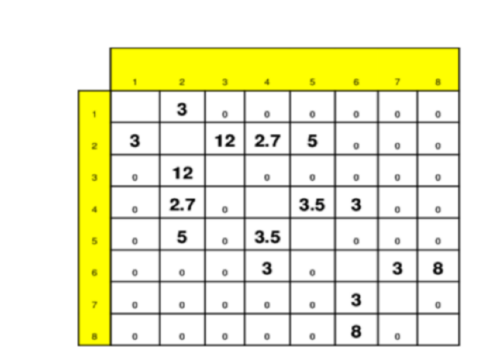
Figure 1. Adjacency